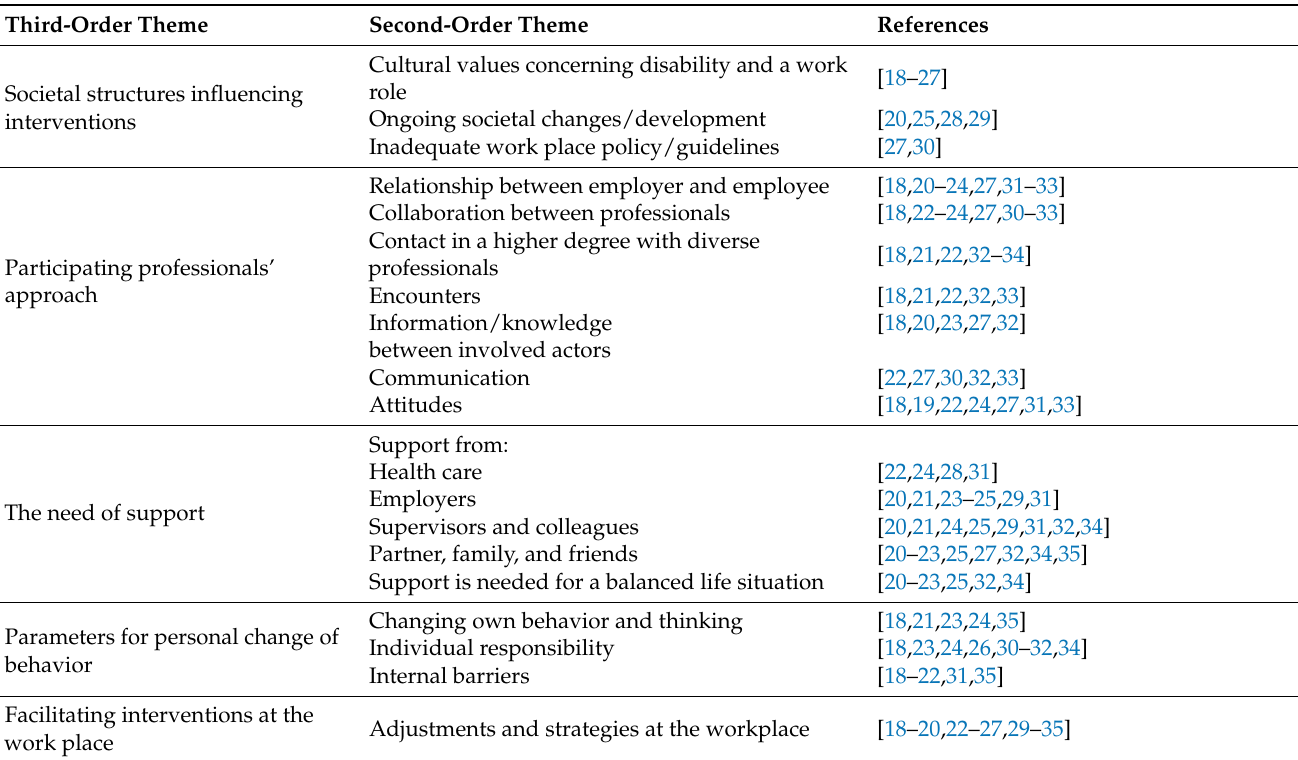
Table 1. Thematic synthesis procedure and corresponding